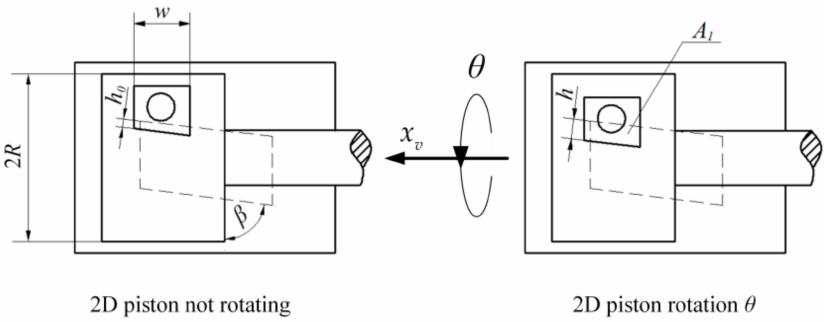
Figure 6. Schematic diagram of 2D piston